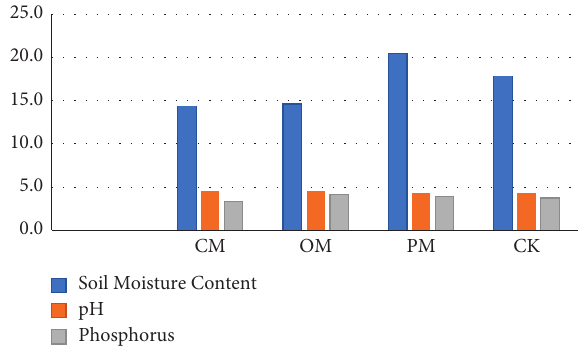
Figure 9: Soil moisture content, pH, and available